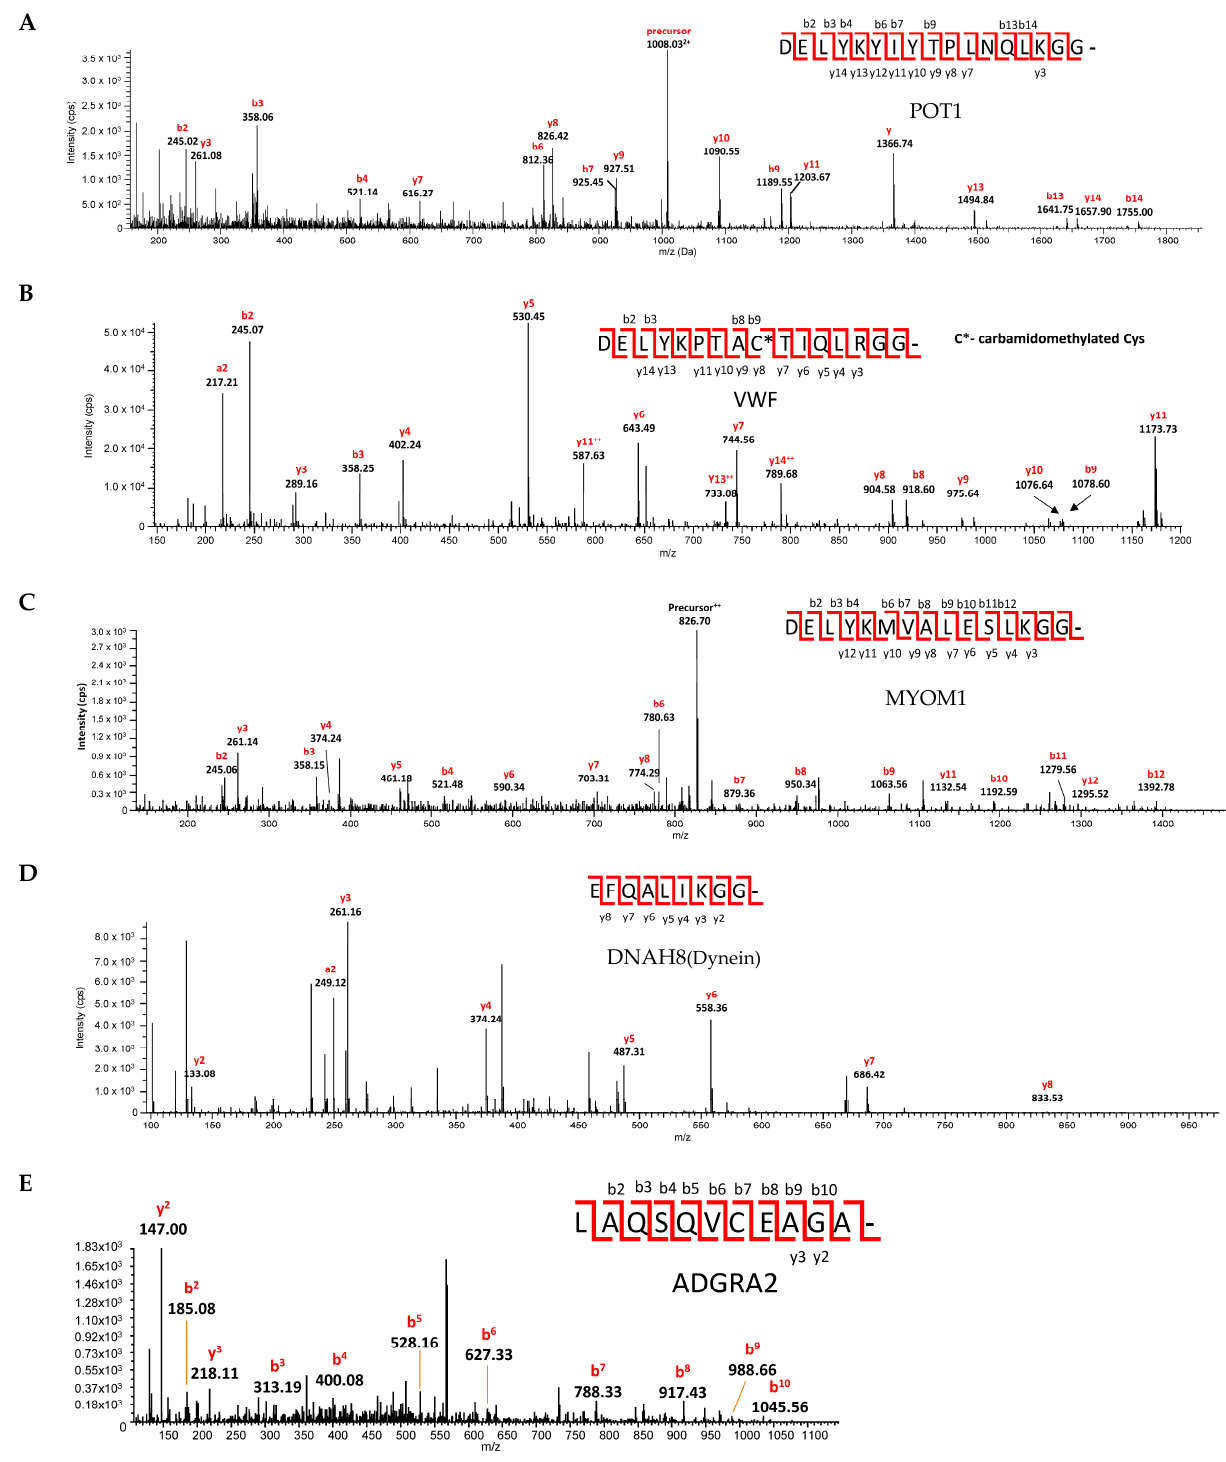
Figure 6. Identification of the scissile bond by tandem LC ‐ MS/MS for SARS ‐ CoV ‐ 2 PLpro cut cyan ‐ yellow fluorescent protein substrates containing predicted cleavage sites in ( A ) protection of teleomeres (POT1), ( B ) von Willebrand factor (VWF), ( C ) myomesin ‐ 1 (MYOM1), ( D ) dynein axonemal heavy chain 8 (DNAH8), and ( E ) ADGRA2. Cleavage products were separated by SDS ‐ PAGE. All proteins were reduced and alkylated in gel and digested by AspN. Peptide mixtures were analyzed by LC ‐ MS/MS. Spectra of the PLpro cut proteins are shown above. All fragments are singly charged unless they are marked with superscript ++.